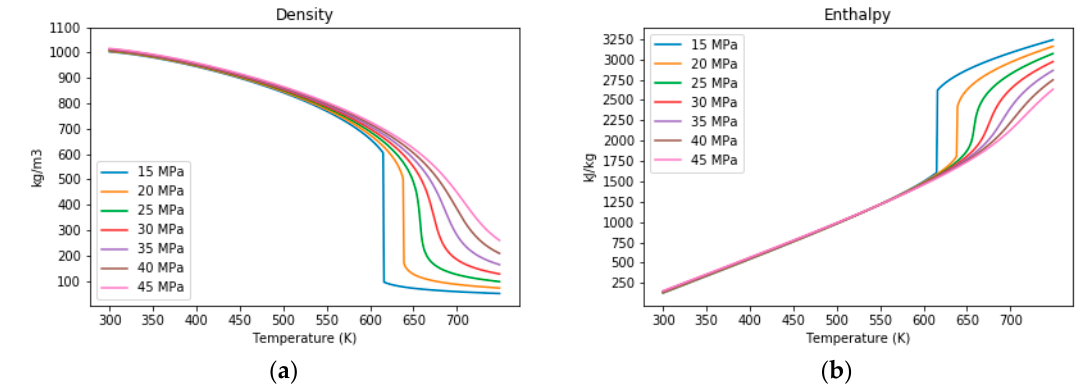
Figure 2. Density and enthalpy of water as a function of temperature at various pressures. The data points are taken from Wagner and Pruß [60]: ( a ) density; ( b ) enthalpy.